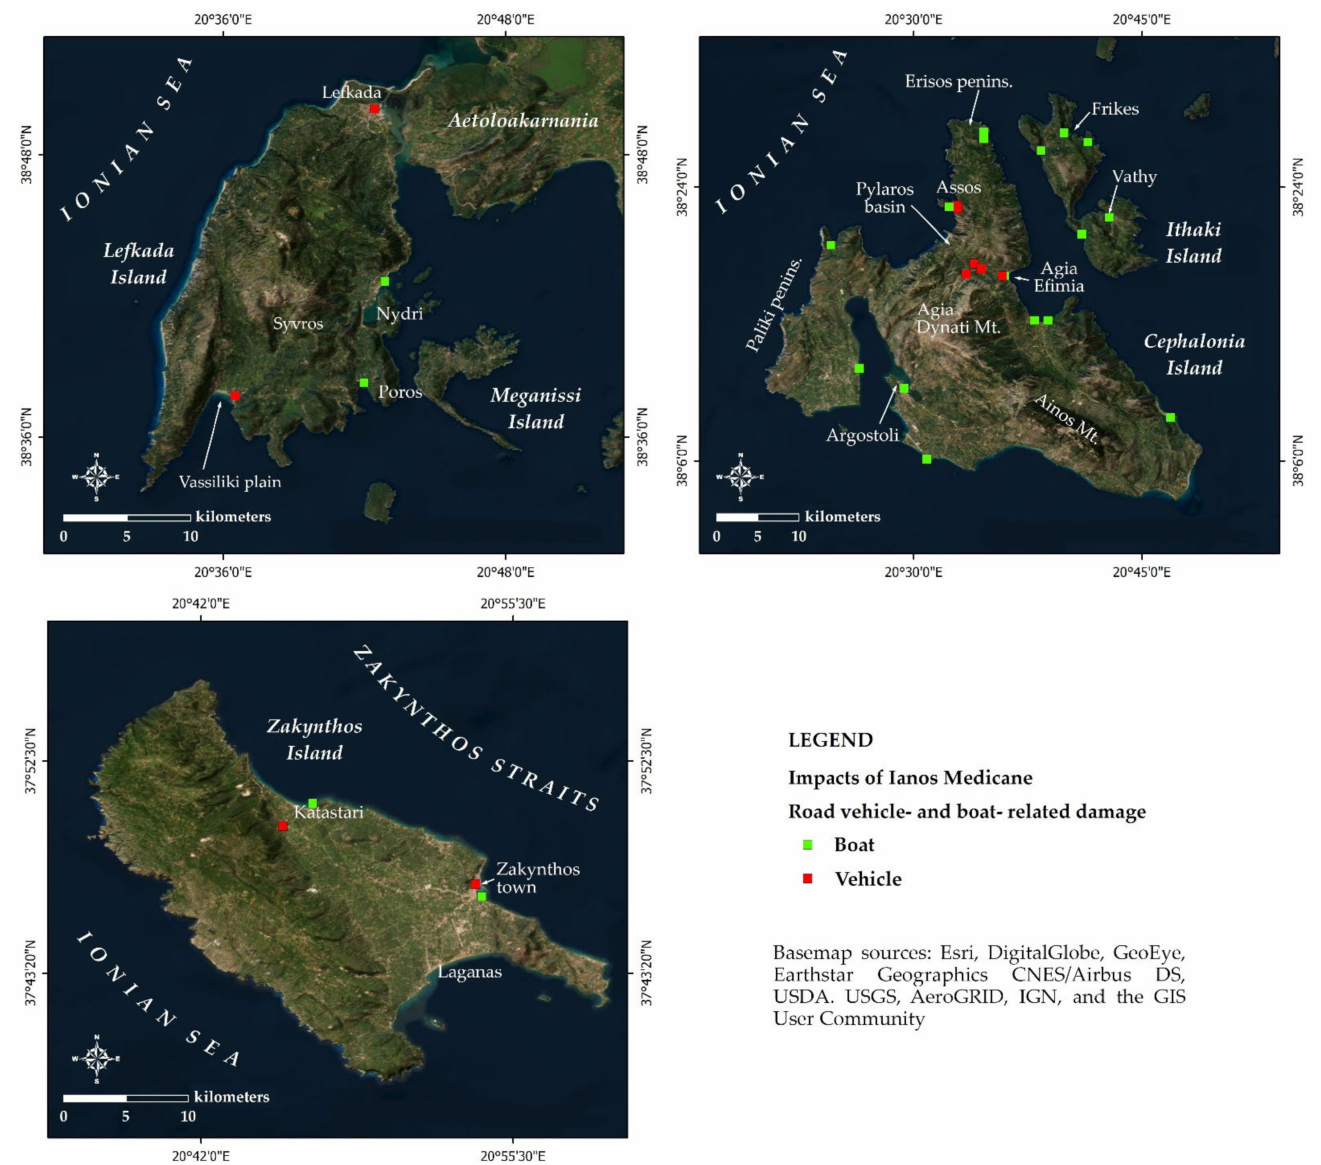
Figure 11. Map illustrating the spatial distribution of effects of Ianos Medicane on road vehicles (red) and boats